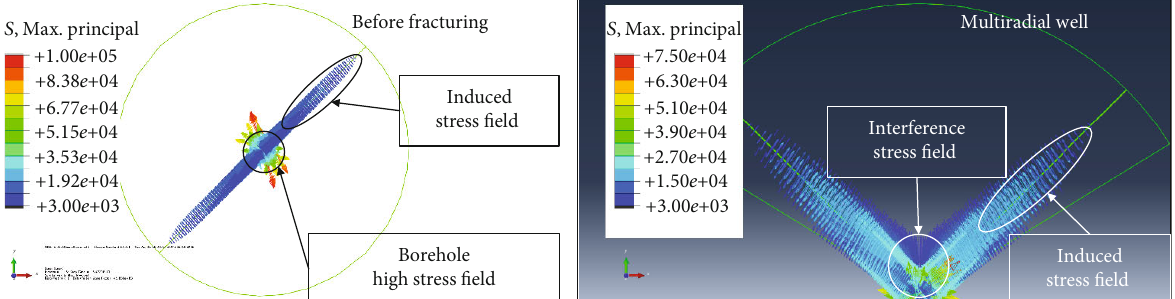
Figure 7: Simulation results of induced stress fi eld and interference stress fi